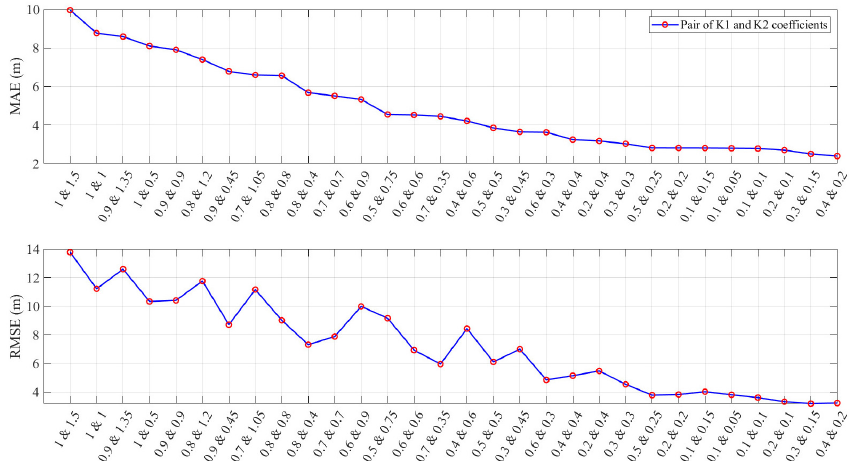
Figure 10. Establishment of the GenCade model from Cua Dai estuary to Cua Lo estuary.